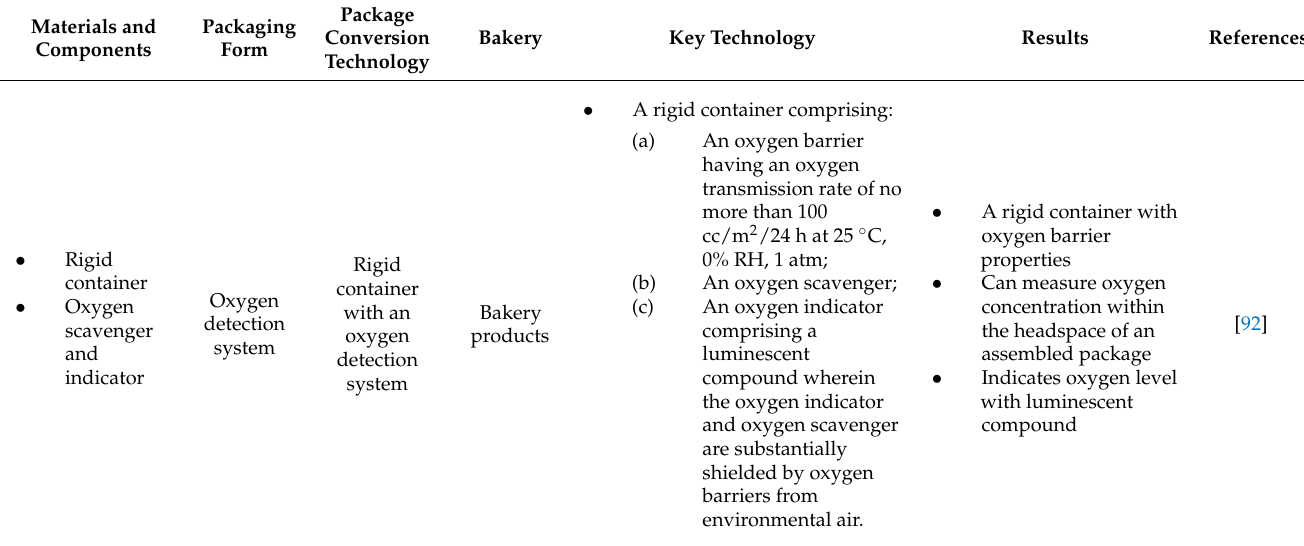
Table 2. Previous recent patents related to packaging technology for bakery